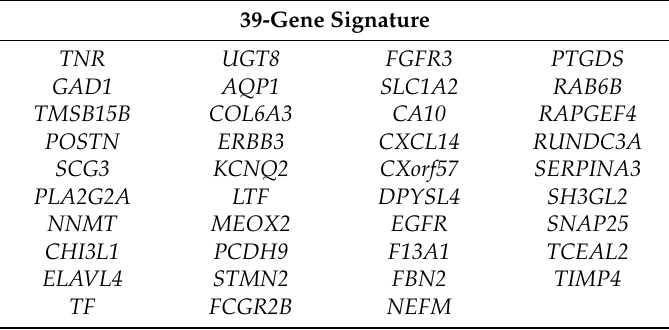
Figure 1. Probability distribution of important genes occurring at different network nodes. It is very rare for an important gene to occur in many nodes that are prognostic to survival. Using a threshold of p < 0.01, only genes that occurred at least 10 out of 27 network nodes meet the criteria and are included in the 39-gene signature. Table 4. Gene list of the 39-gene signature selected based on p < 0.01 occurrence at the deep-learned network nodes at the top hidden layer.